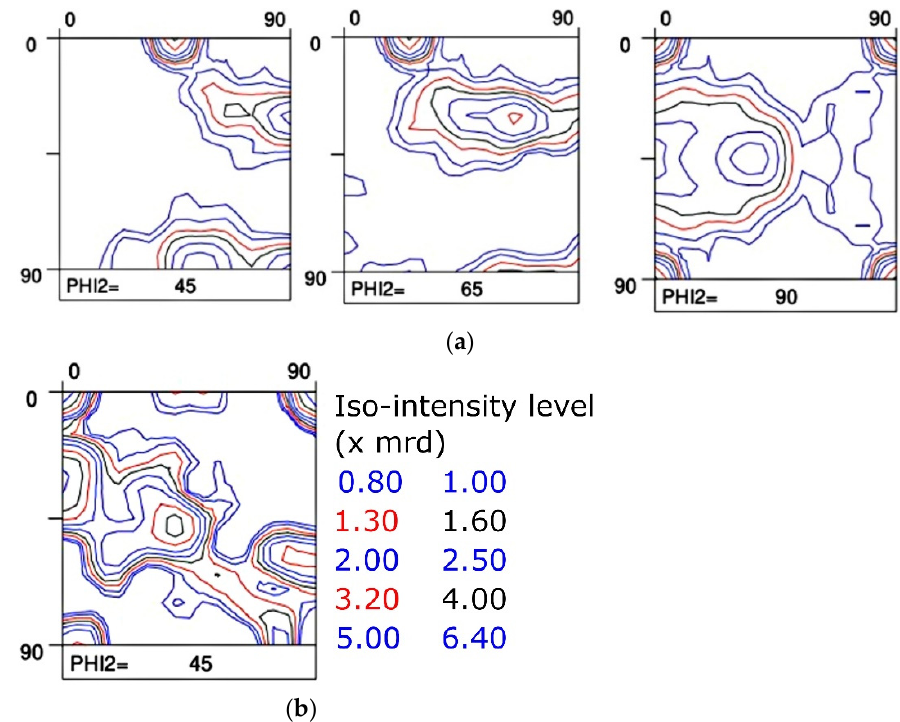
Figure 7. ( a ) Reconstructed austenite texture corresponding to the map in Figure 5b applying the NW orientation relationship ( φ 2 = 45°, 65° and 90° sections) and ( b ) φ 2 = 45° product texture derived from ( a ) by applying the double NW variant selection